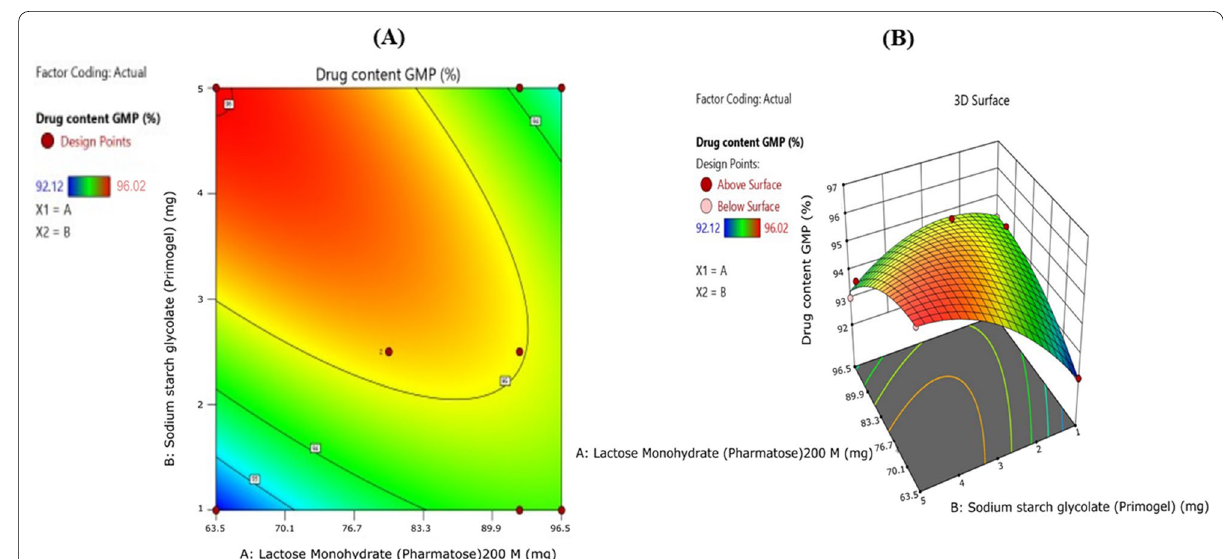
Fig. 3 A Contour plot and B Response surface plot for dependent variables of GMP-IR pellets with drug content as a